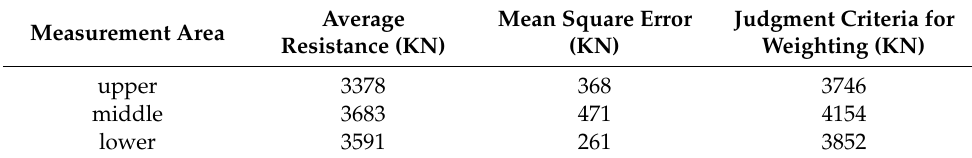
Table 3. Criteria for weighting of hydraulic supports.